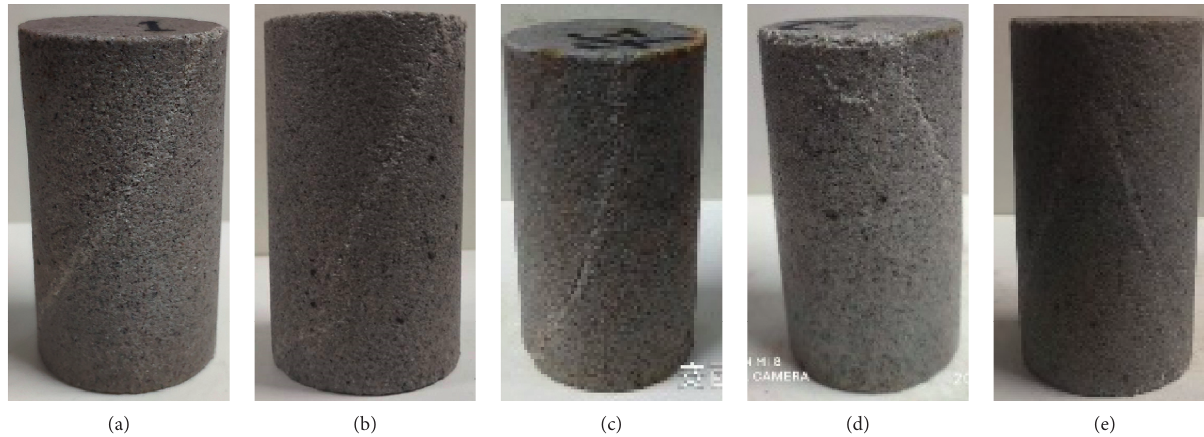
Figure 5: Typical specimen-fracture characteristics. (a) No pore pressure. (b) 0.1 MPa pore pressure. (c) 0.2 MPa pore pressure. (d) 0.4MPa pore pressure. (e) 0.6MPa pore pressure.